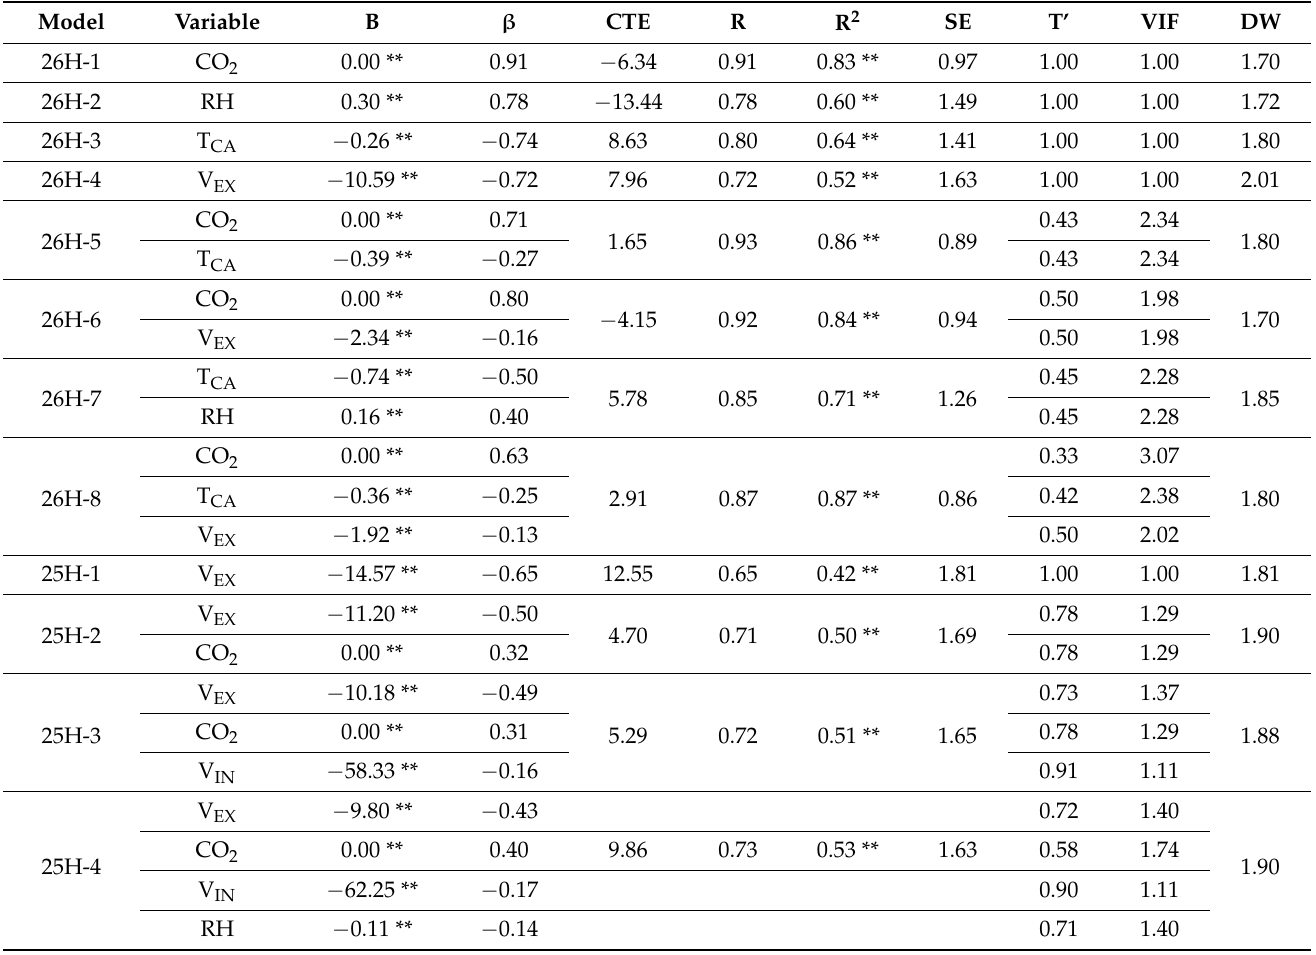
Table 2. Non-standardized coefficients (B), standardized coefficients ( β ), constants (CTE), correlation coefficients (R), adjusted determination coefficients (R 2 ), standard errors (SE), collinearity statistics (T’ and VIF) and Durbin Watson statistics (DW) for the estimation of NH 3 from multiple regressions with the variables: CO 2 , RH, T CA and V EX for hourly data (H) and T S 26 or 25 ◦